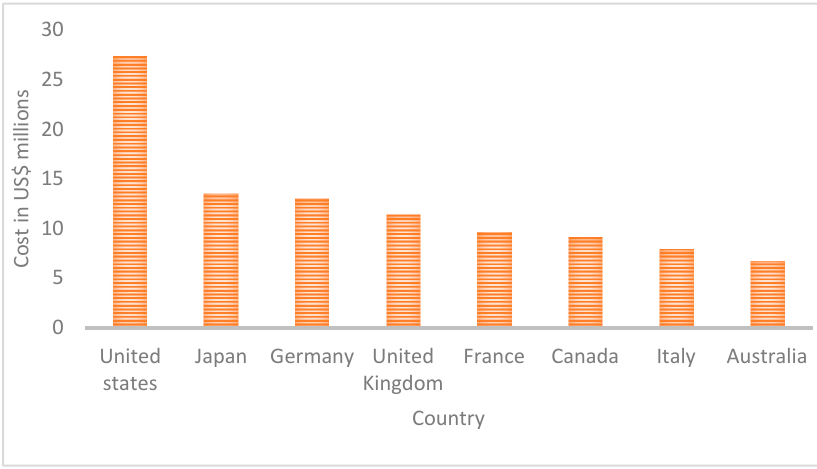
Figure 1. Total cost of Cyberattacks in various countries source [18].